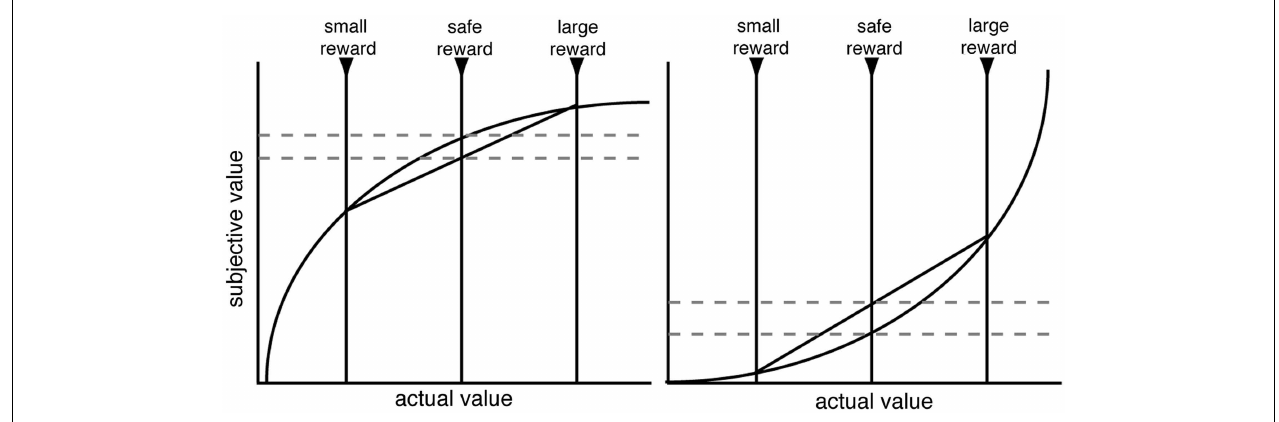
expected value.With concave (or convex) utility curves, the expected utility is lower (higher) than the expected value.While utility functions are undoubtedly non-linear, it remains unclear whether the utility curve argument is sufficient to explain the range of risk preferences in macaques.